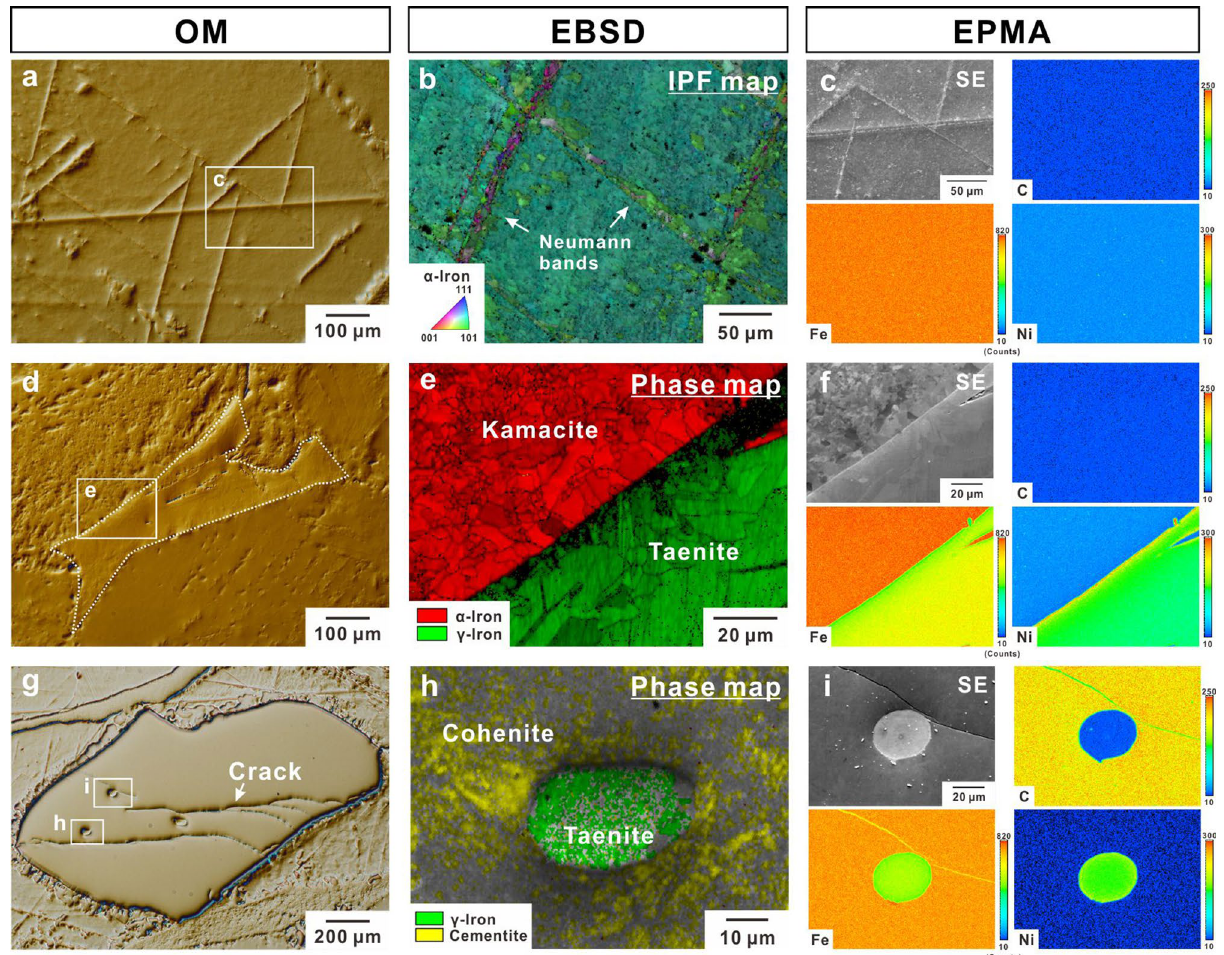
Figure 1. Microstructural characterisation of Canyon Diablo meteorite. ( a , d , g ) Optical micrographs showing kamacite, taenite, and cohenite, respectively. ( b , e , h ) EBSD maps in kamcite, taenite/kamacite boundary, and cohenite, respectively. ( c , f , i ) Comparison of secondary electron image and corresponding elemental maps of carbon, iron, and nickel in the areas shown in ( a ), ( e ), and ( g ), respectively. Colour bars in elemental maps indicate the characteristic X-ray intensity proportional to the elemental